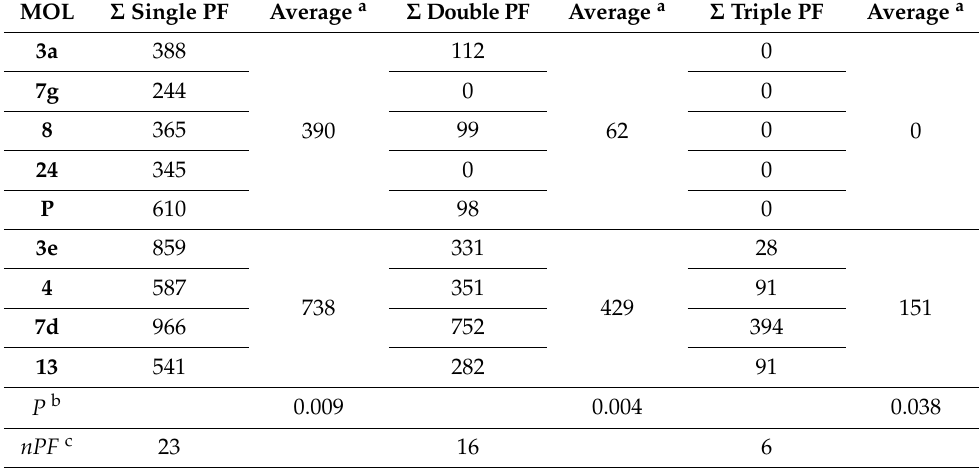
Table 6. Proximity